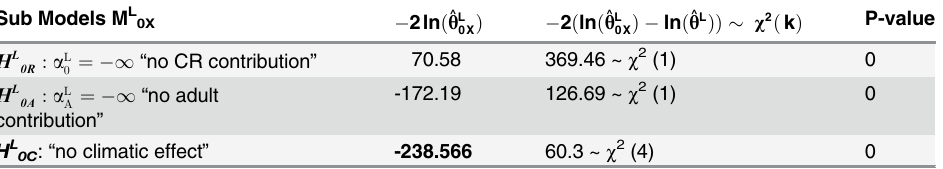
Table 2. Larva presence: Hypothesis testing on covariate effect.